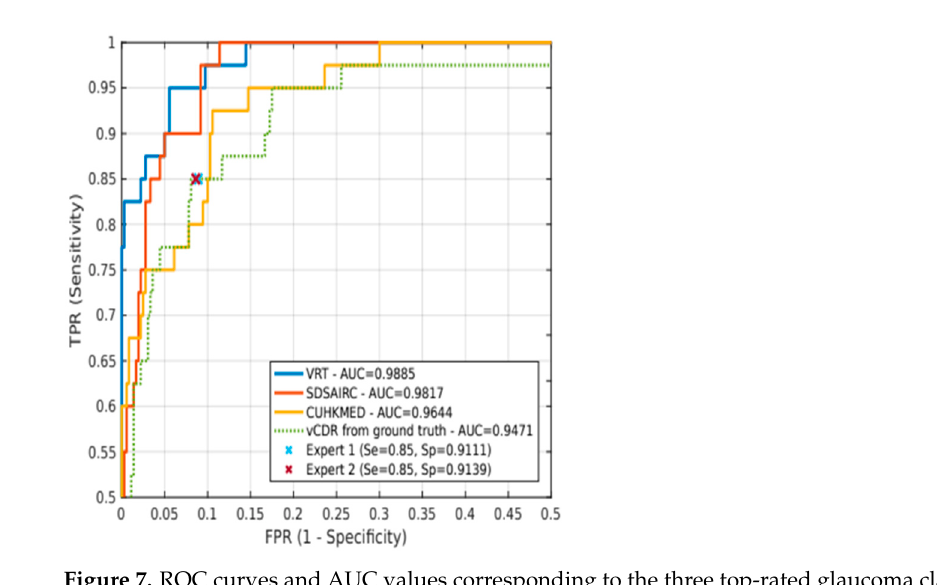
Figure 7. ROC curves and AUC values corresponding to the three top-rated glaucoma classification methods (solid lines) and the vertical cup-to-disc ratio (green dotted line). Crosses indicate the operating points of two experts.